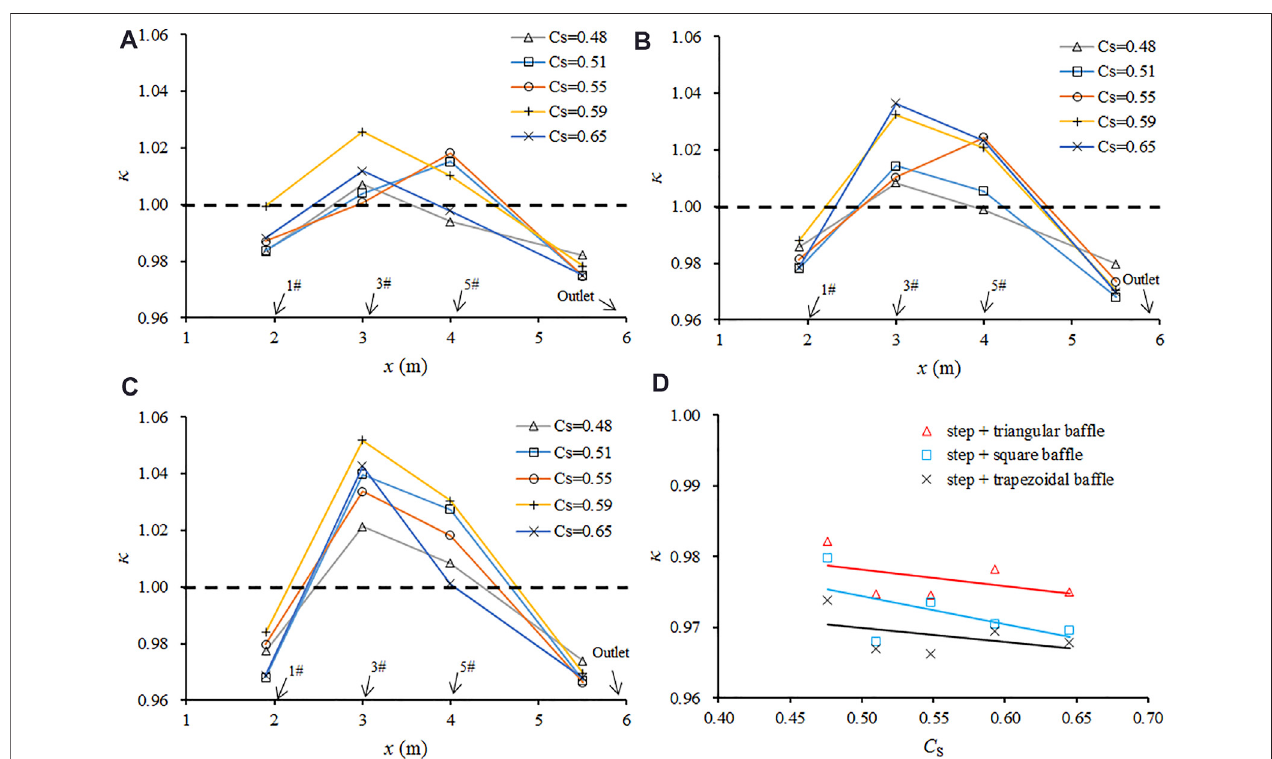
FIGURE 7 | The sediment-trapping ratio for the (A) triangular baf fl e; (B) square baf fl e; (C) trapezoidal baf fl e; and (D) channel outlet.